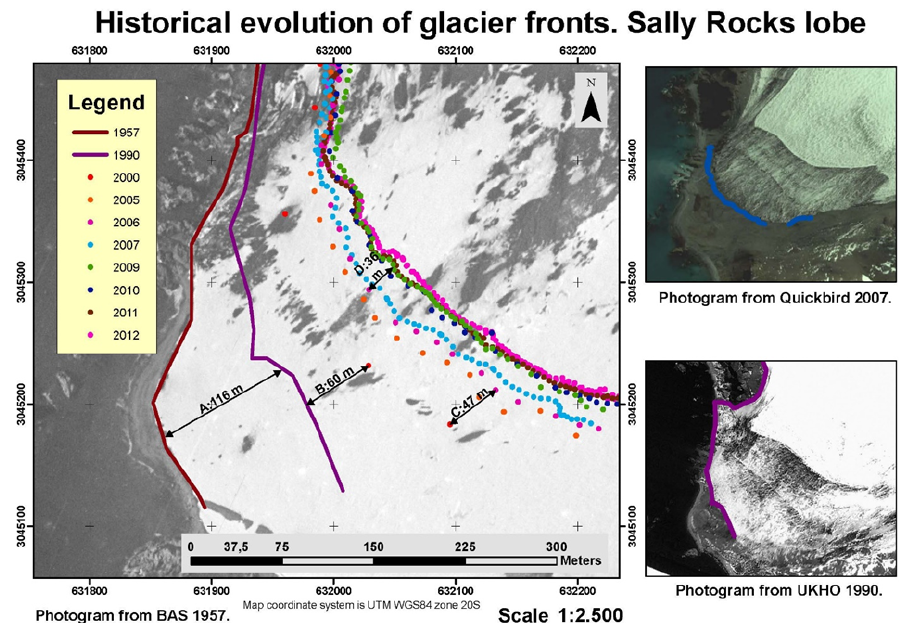
Figure 10. Terminus position changes of Sally Rocks front of Hurd Glacier. The oldest front position available corresponds to 1957 (in purple) and the latest to 2012 (in cyan). The base map corresponds to the BAS aerial photograph of 1957. The scale bar shown in the figure does not match with the map scale indicated.